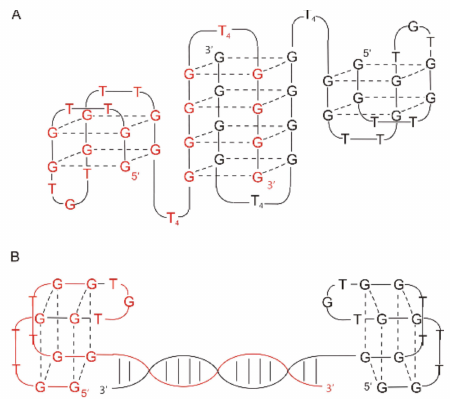
Figure 14. The structure of T4T4 ( A ) and HD1-ds ( B ) [35].